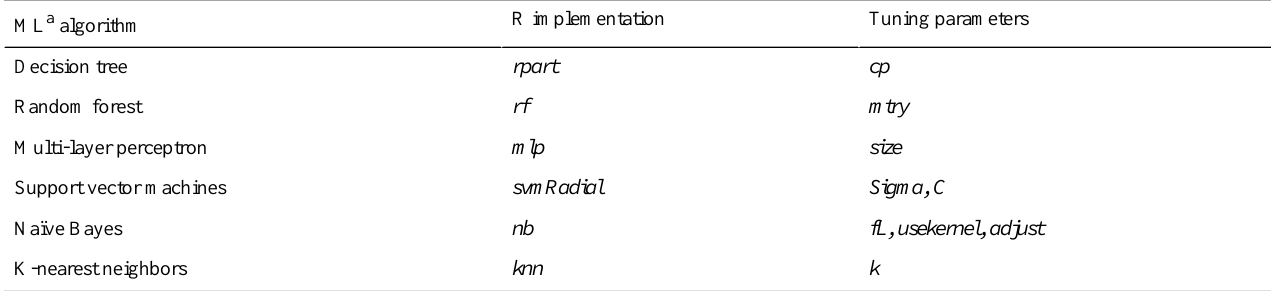
Table 4. Configuration of the R algorithms included in the